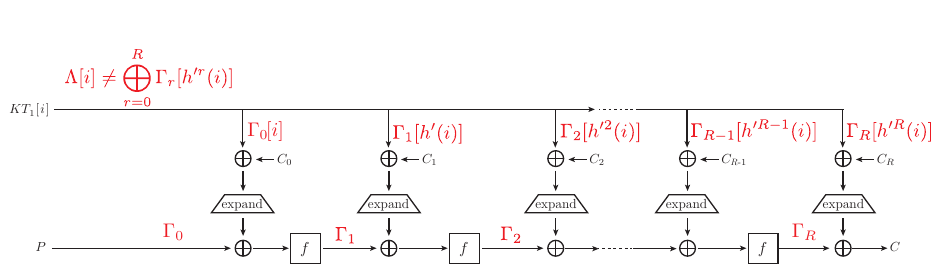
Figure 10: Zero-correlation linear hull on the STK with TK